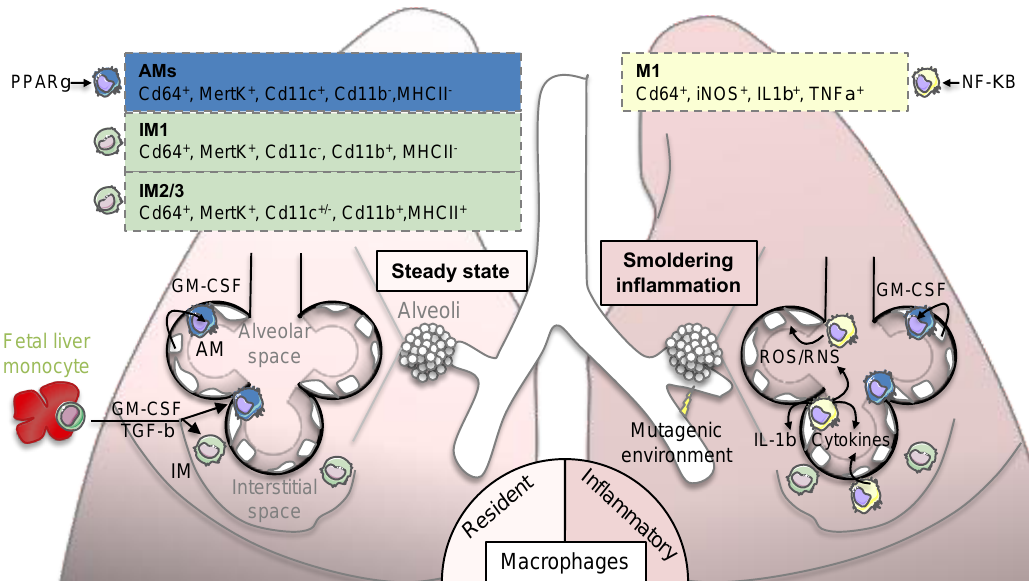
Figure 1. Lung macrophage origin and contribution to “smoldering inflammation”. Left panel: lung-resident macrophages are derived from fetal liver monocytes originating during embryogenesis. The genesis and self-maintenance of macrophages depend on granulocyte-macrophage colony-stimulating factor (GM-CSF) and transforming growth factor β (TGF- β ). Four populations of macrophages are present in the lung and are defined by their locations and expression of specific cell surface markers (please refer to boxes): alveolar macrophages (AMs) reside in the airspaces of lung where they self-renew thanks to GM-CSF-expressing alveolar cells. AMs express peroxisome proliferator-activated receptor γ (PPAR γ ) to maintain lipid homeostasis most likely required for surfactant lipid recycling. Three interstitial macrophage (IMs) populations are located in the lung interstitium and have potential immunoregulatory properties. Right panel: upon exposure to irritant particles or chronic inflammation, macrophages can be primed into an inflammatory M1 phenotype participating to a “smorldering inflammation”. This inflammation is illustrated by the secretion inflammatory cytokines such as interleukin-1 β (IL-1 β ) or tumor necrosis factor α (TNF α ) that are under the control of the transcriptional factor NF-kB and the production of reactive oxygen or nitrogen species (ROS/RNS) that favor the induction of somatic mutations in surrounding epithelial cells.